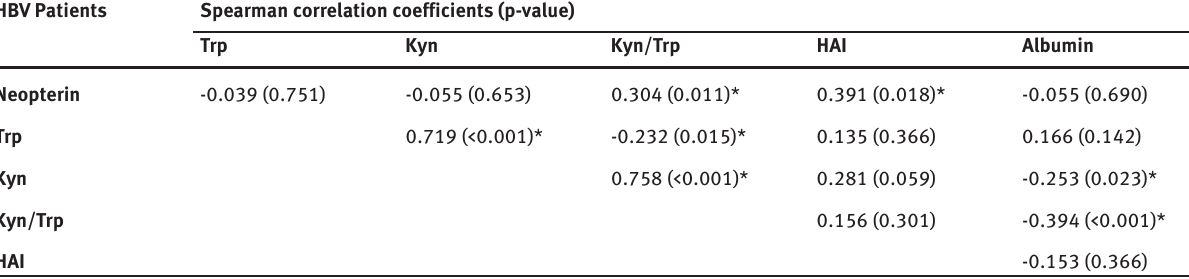
Table 2: Correlations between the parameters in HBV patients.